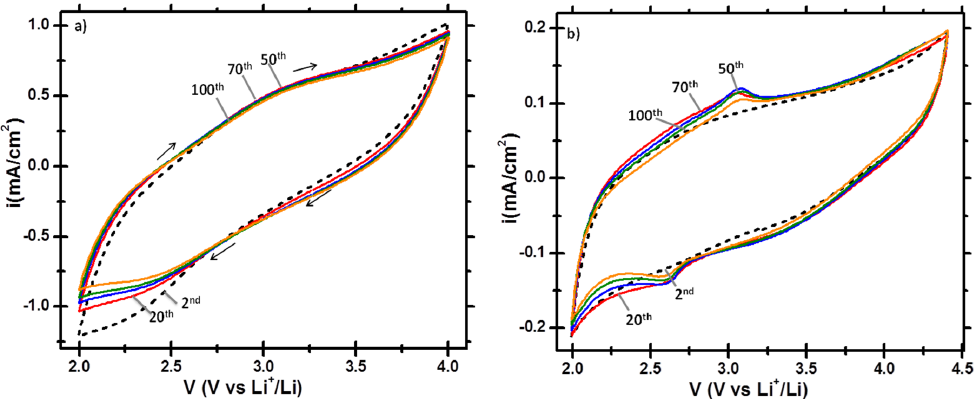
Figure 7. Cyclic voltammograms for Li ‐ ion insertion (cathodic) and extraction (anodic) for ( a ) 230 nm EMD and ( b ) 70 nm EMD anodically deposited on C/TiN/Si pillars obtained in 1 M LiClO 4 / propylene carbonate at a scan rate of 10 mVs − 1 . Cycles 2, 20, 50, 70 and 100 are shown for a total of 100 consecutive cycles. The EMD films were deposited at 4.5 mA/cm − 2 and annealed at 350 °C in N 2 atmosphere for three hours.